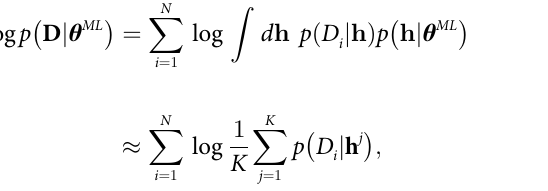
Table 1. iBIC scores for different models. Learn ( σ , δ ). Set C loss = 1, P Lapse = 0. 1 Learn ( σ , δ , P Lapse ). Set C loss = 1. 3 Learn ( σ , δ , C loss ). Set P Lapse = 0. 3 Learn ( σ , δ , C loss , P Lapse ).